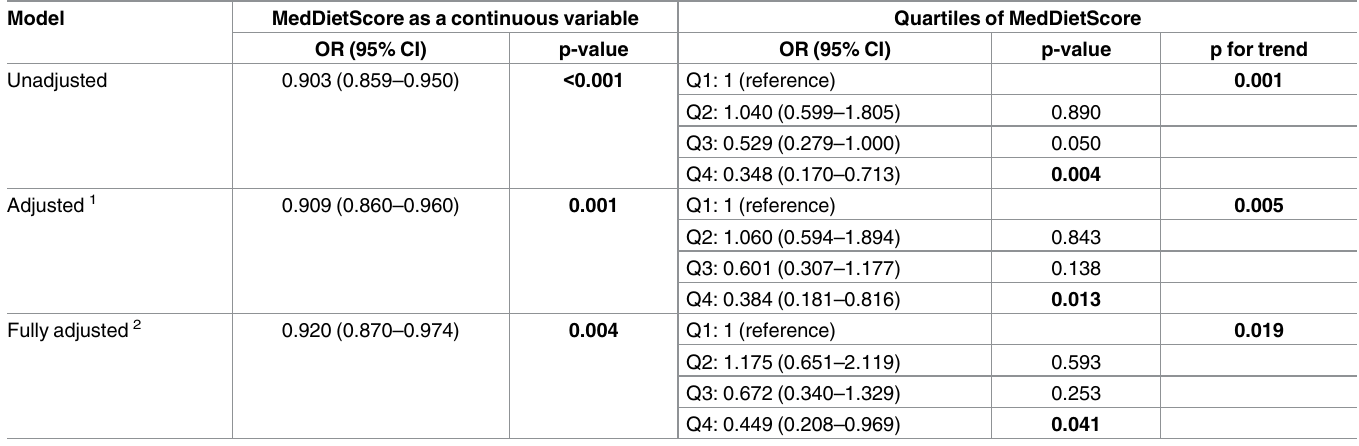
Table 3. Results from logistic regression analysis that evaluated the association between the Mediterranean dietary score and dementia. Model